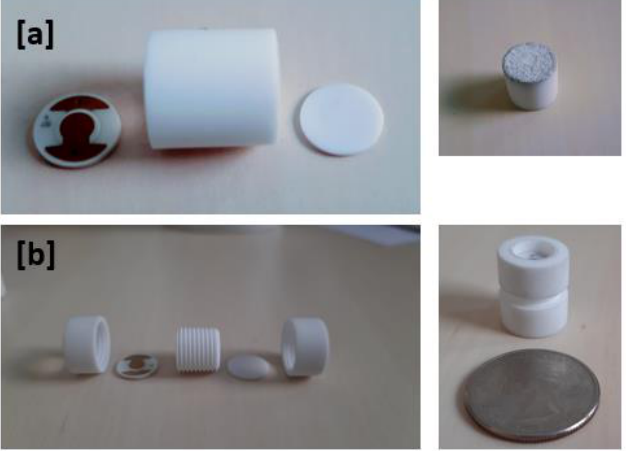
Figure 4 : [a] Design n°1 before and after the sealing step with alumina cement [b] Design n°2 of the screwed version before and after its assembly